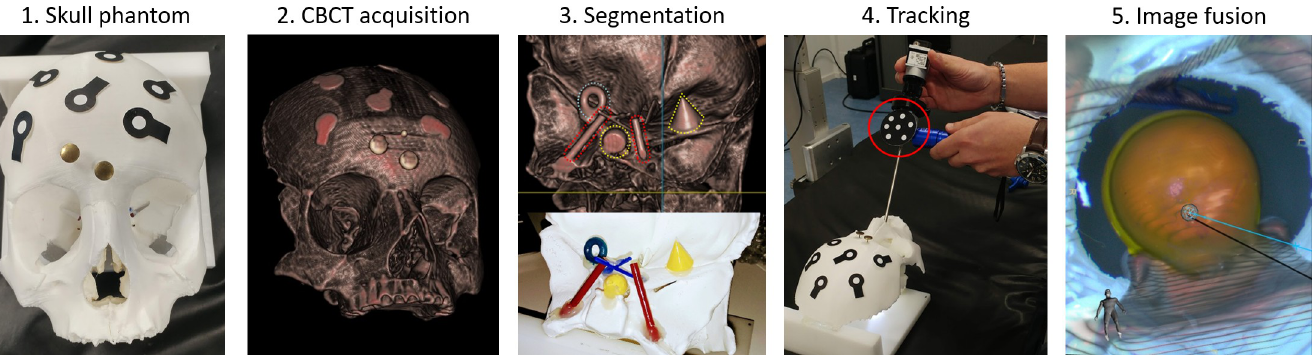
Fig 4. Relationship of the frame